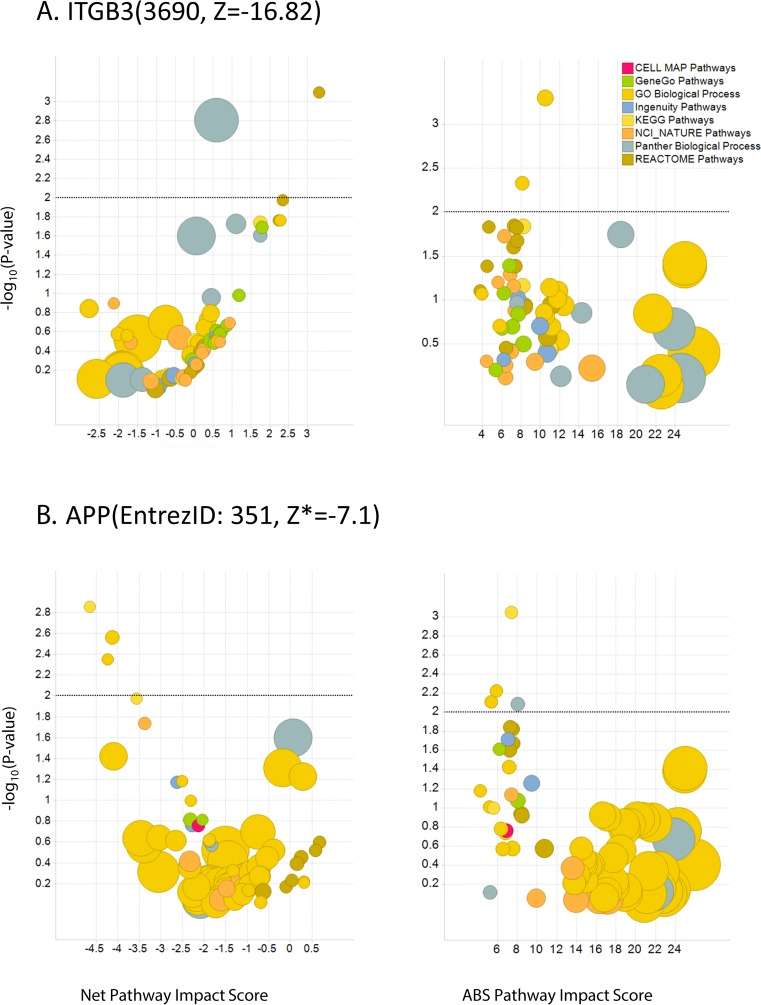
Pathway/process context matters.Not all pathways/processes that contain genes with extreme values are significant suggesting that the approach may be resistant to to outliers. For example, ITGB3 and APP are clear outliers with Z* scores of 7.18 and -7.1, respectively but not all of their corresponding pathways/processes were found to be significant regulators of Aβ42. Each circle corresponds to pathway/process and the size corresponds to the number of genes in that pathway/process. Y-axis represents the likelihood of a pathway of a given size to have the corresponding net or absolute PI score by chance. Black dotted line corresponds to p-value = 0.01 or -log10(p-value) = 2 and the x-axis corresponds to the either Net or ABS PI score based on the Aβ42 readout.